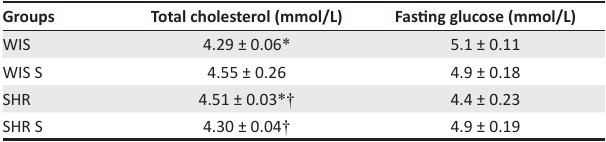
TABLE 3: Effect of multivitamin-multimineral supplementation on total cholesterol and fasting blood glucose in spontaneously hypertensive and Wistar rats for week eight. Groups